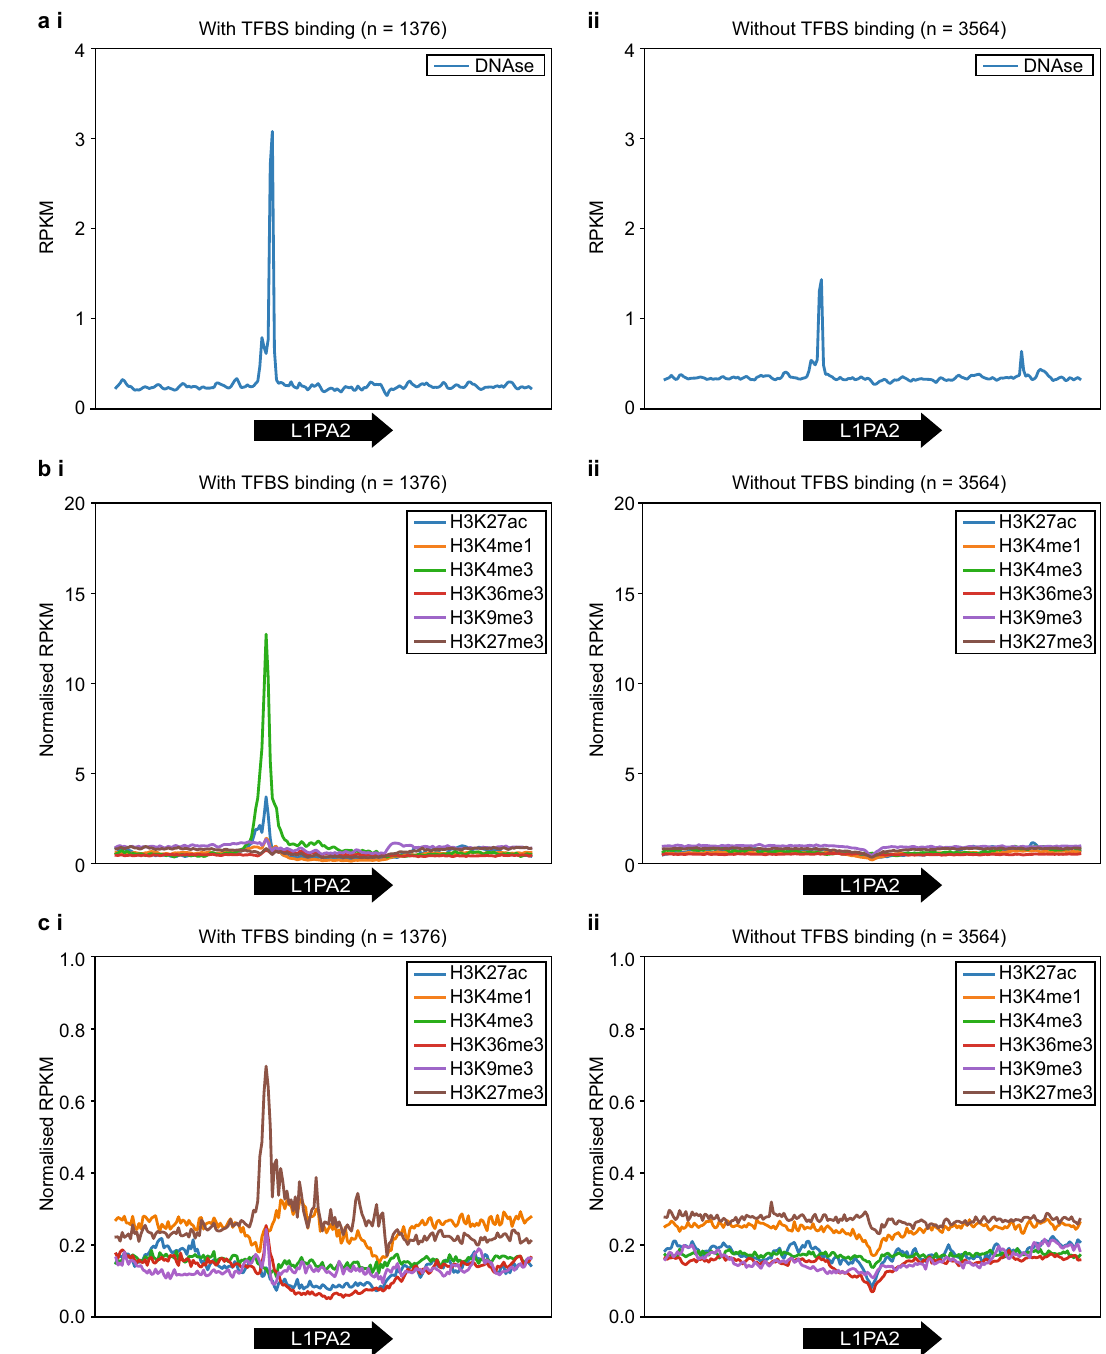
Figure 2. TF binding in L1PA2 was correlated with active epigenetic marks in MCF7 cells. In MCF7 cells, L1PA2 transposons bound by TFs were associated with ( a ) increased DNAse sensitivity ( b ) active histone tail modifications. ( c ) However, in the normal mammary tissues, TF binding in L1PA2 transposons was counteracted by repressive histone tail modifications. The average RPKM values of the DNAse-seq data and the normalised RPKM values of histone modification ChIP-seq data are shown for the 20 kb region (bin = 100 bp) centred on L1PA2 transposons ( i ) with, and ( ii ) without TFBSs. Average RPKM values were calculated by averaging the raw RPKM values of each epigenetic mark across the replicates. Normalised RPKM values were calculated by normalising the average RPKM values to the control ChIP-seq data by subtraction. Black arrows indicate the position and orientation (5 ′ to 3 ′ ) of L1PA2